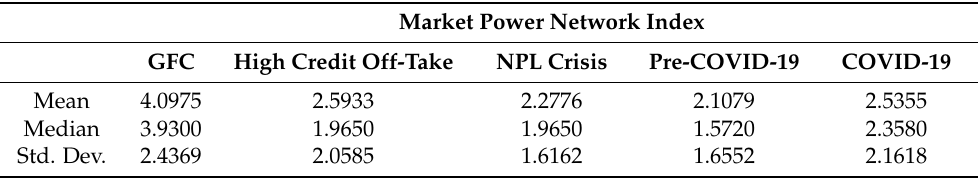
Table 3. Descriptive statistics of Market Power Network Index for different periods.